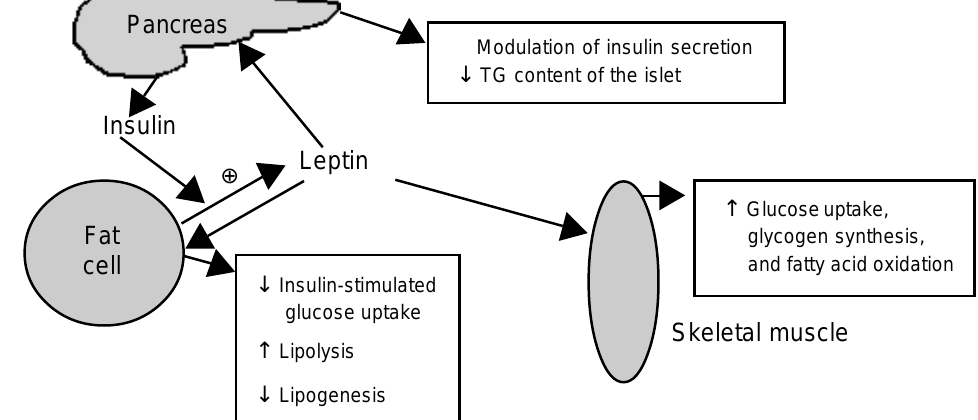
Figure 2 - Summary of the piv- otal role of leptin in insulin se- cretion and insulin responsive- ness in skeletal muscle and adi- pocytes. ¯ stimulates, › in- crease, fl decrease. TG, Triglyc-